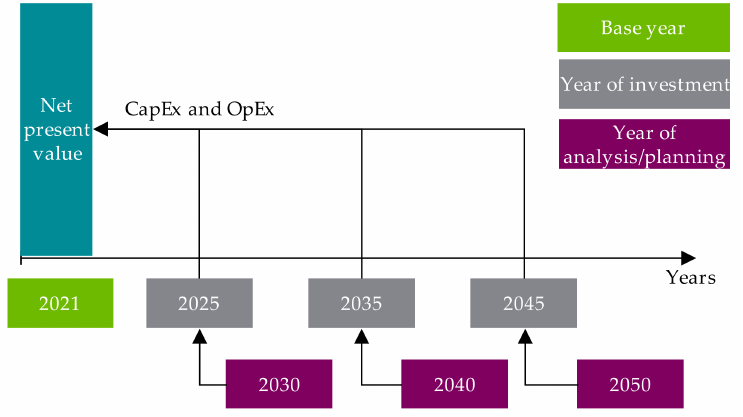
Figure 13. Method of the primary assessment model based on the determination of the net present